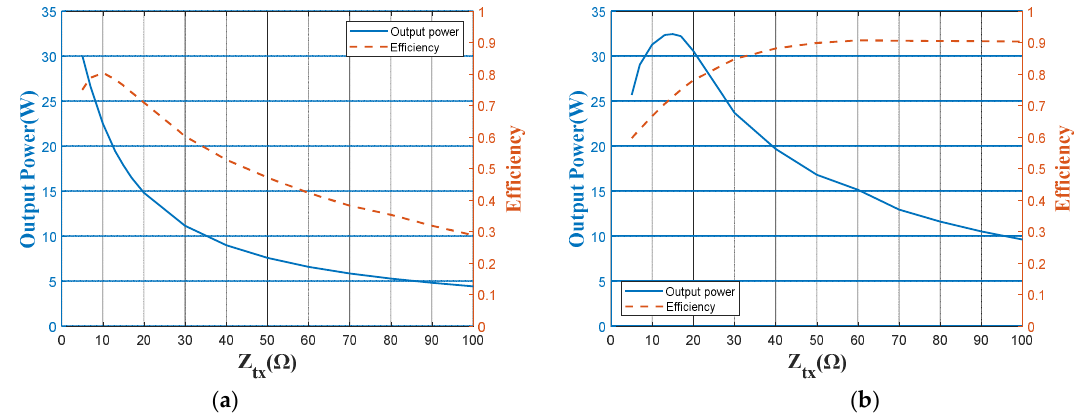
Figure 7. Output power and efficiency of Class-E2-based WPT system: ( a ) without double-L-type IMN; ( b ) with double-L-type IMN. Table 1. Design parameters of Class-E2-based WPT system.